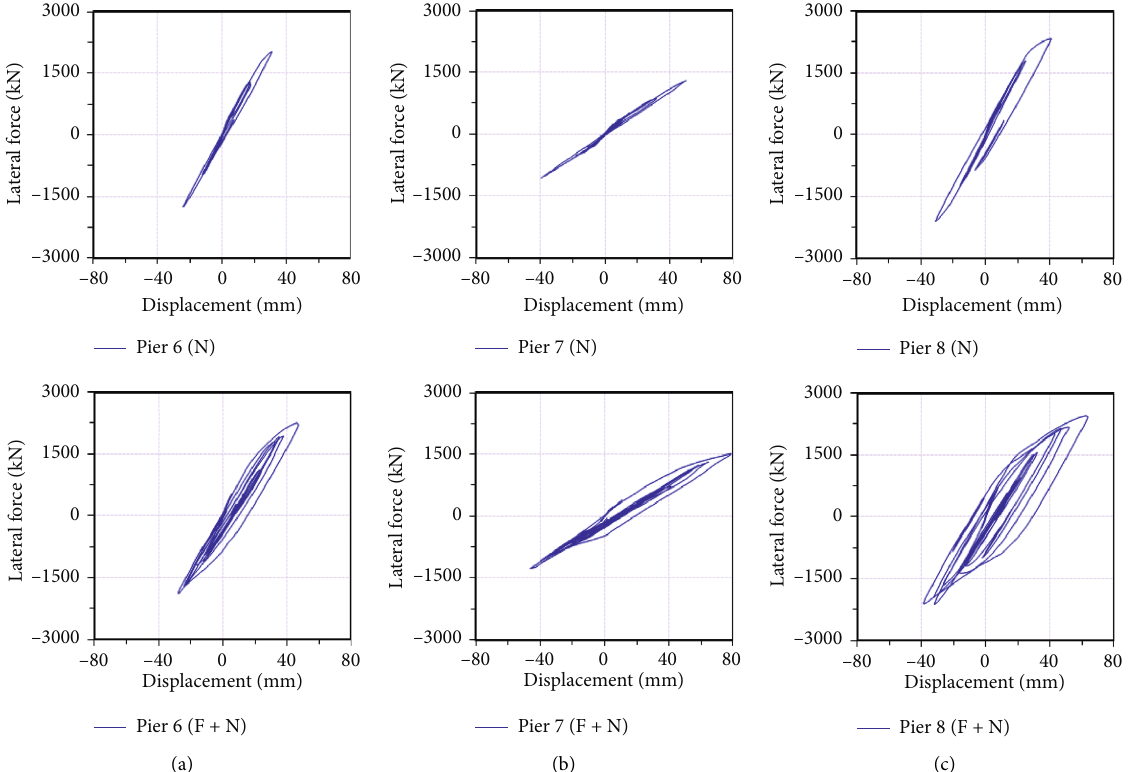
Figure 8: Transverse hysteretic response of the flexure-axial model subjected to biaxial input ground motions of N and F+N earthquakes. (a) Pier 6. (b) Pier 7. (c) Pier